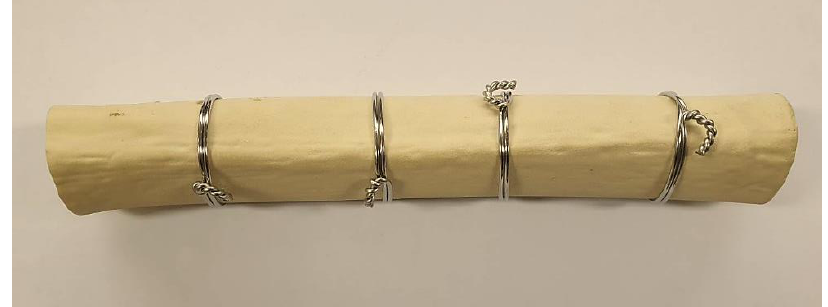
Figure 2. An example of fracture bone bundled with cerclage wires.